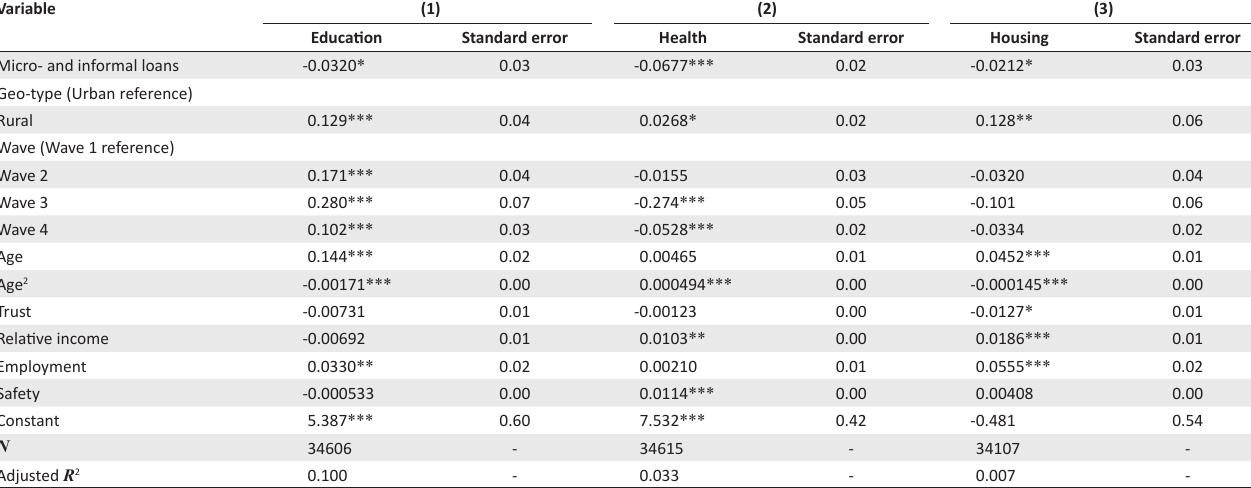
TABLE 1-A1: Comparative estimations result with education, health and housing alternatively used as dependent variables.